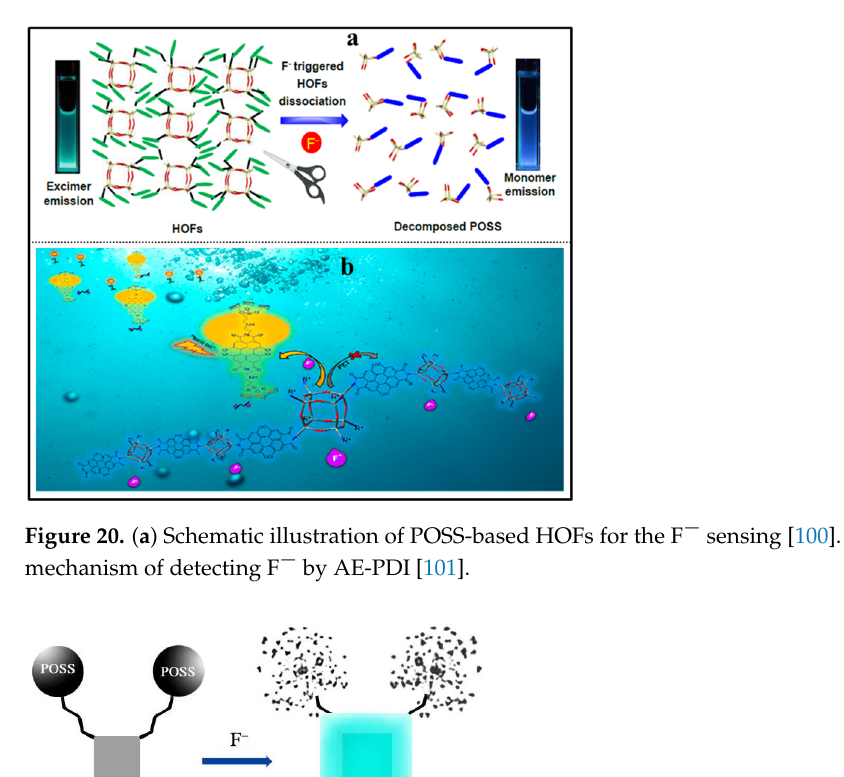
Figure 19. ( a ) Schematic representation of NP structure self-assembled from the POSSPBI-PEO and fluoride ion sensing process in water [98]. ( b ) Schematic representation of PySQ for fluoride ion sensing process in DMSO [27].